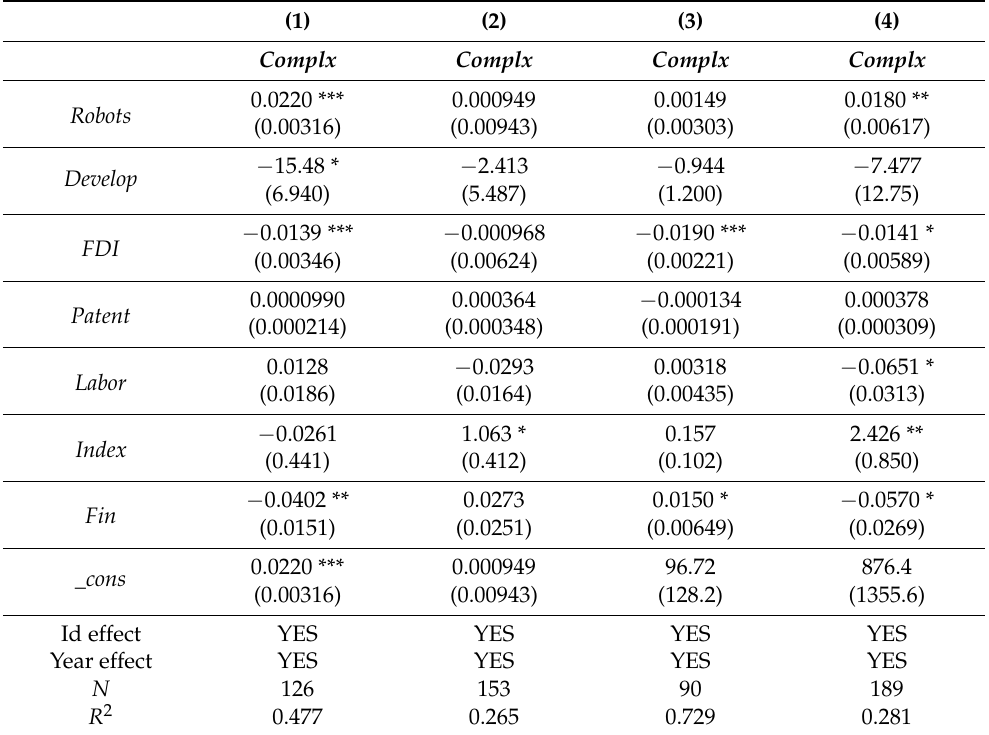
Table 6. Heterogeneity